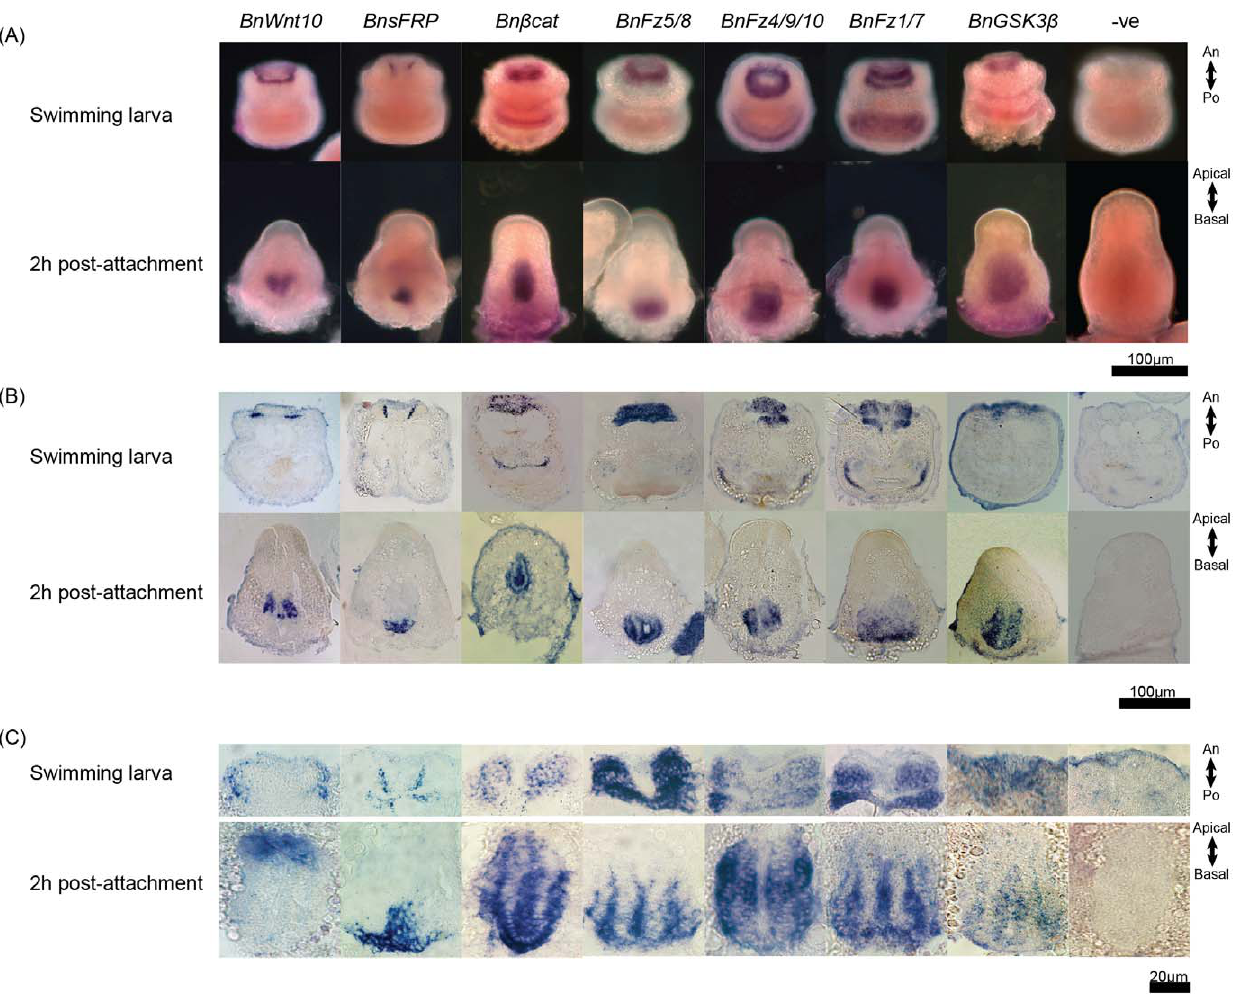
Figure 4. Expression of BnWnt10 , BnsFRP , Bn b cat , BnFz4/9/10 , BnFz5/8 , BnFz1/2/7 , BnGSK3 b in the larval and early pre-ancestrula stages. ( A ) WISH and ( B ) a representative section of WISH showing BnWnt10 is always expressed spatially opposite to BnsFRP while the downstream components of the Wnt pathway, including Bn b cat , BnFz4/9/10 , BnFz5/8 , BnFz1/2/7 , BnGSK3 b , are expressed throughout the blastemas. (C) Images from distinct regions with gene expression signal as shown in (B) were captured using high power (100 6 ) objective. An: anterior; Po: posterior.